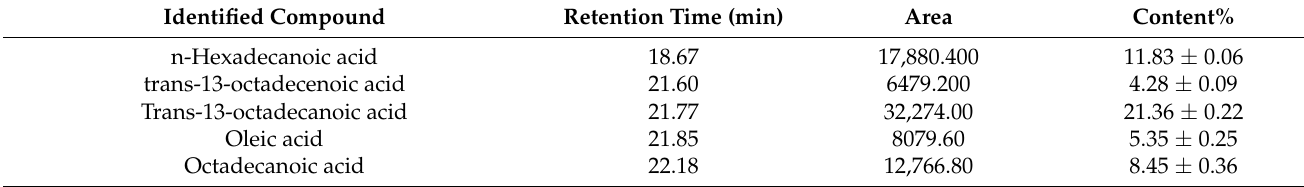
Table 8. The tentative identification of the main compounds in S. vulgaris fruit extract by GC-MS analysis. Identified